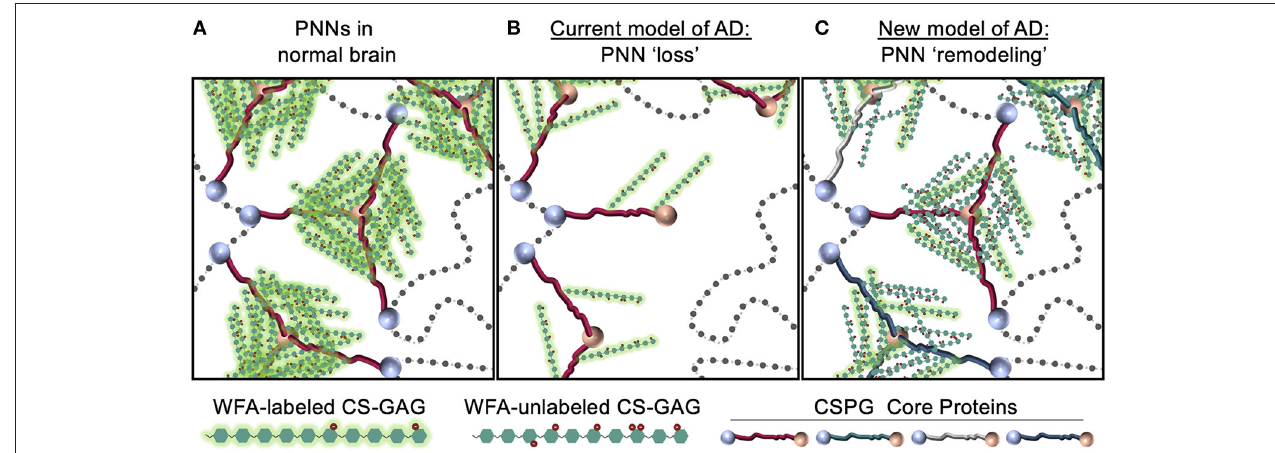
FIGURE 9 | Models depicting PNN “loss” in AD. In contrast to (A) normal brain, which contains stable WFA + PNN structures, the (B) current model describing PNN “loss” in AD proposes that this neurological disease associates with full degradation of the PNN matrix. In response to current evidence that show postmortem AD brain tissue correlates with increased PNN core protein expression and changes in CS-GAG sulfation patterns, we provide (C) an updated model describing PNN “remodeling” as a core feature of the AD brain. This remodeling event associates with a decrease in WFA + PNNs not through matrix degradation but instead through changes in WFA lectin recognition of the hypersulfated diseased CS-GAGs. This new model also considers AD-driven changes in CSPG core protein variants that may support fewer CS-GAG glycan attachments. WFA, Wisteria floribunda agglutinin; PNNs, perineuronal nets; CS-GAG, chondroitin sulfate-glycosaminoglycan; CSPG, chondroitin sulfate